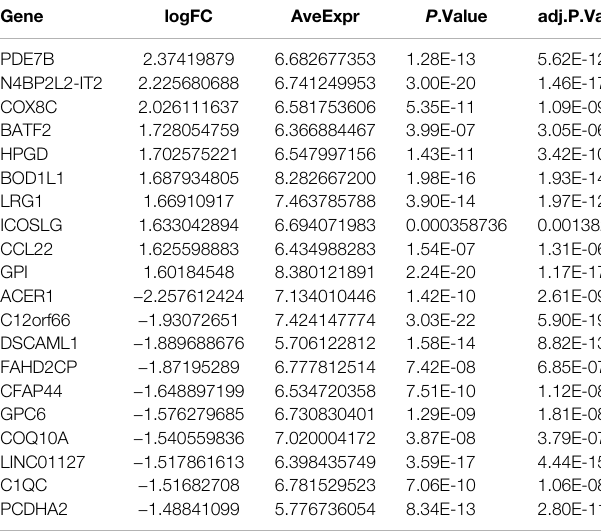
TABLE 4 | The top 10 upregulated and downregulated DEGs between cluster 3 and cluster 4. Gene logFC